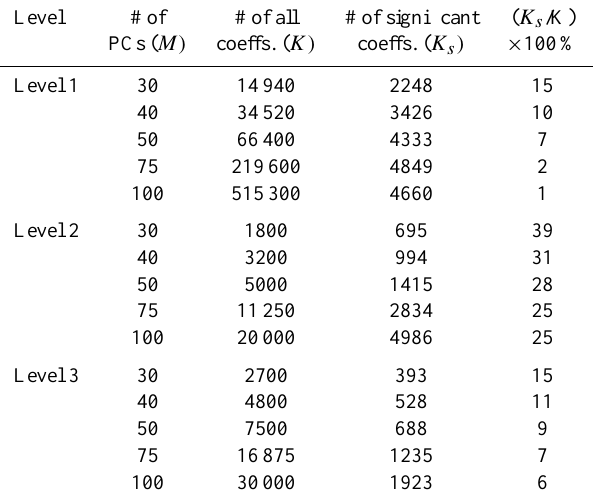
Table 2. The number of statistically significant coefficients of a three-level quadratic inverse model based on M leading PCs of SLW (see Appendix B for further